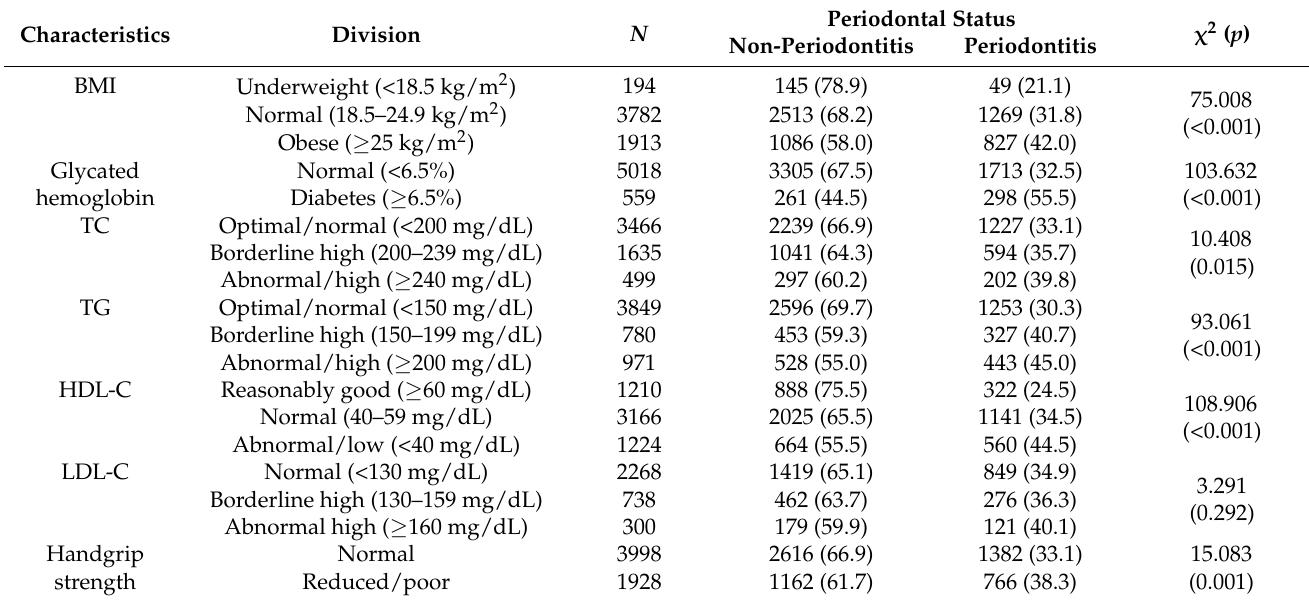
Table 2. Association between systemic health conditions or handgrip strength and periodontitis.